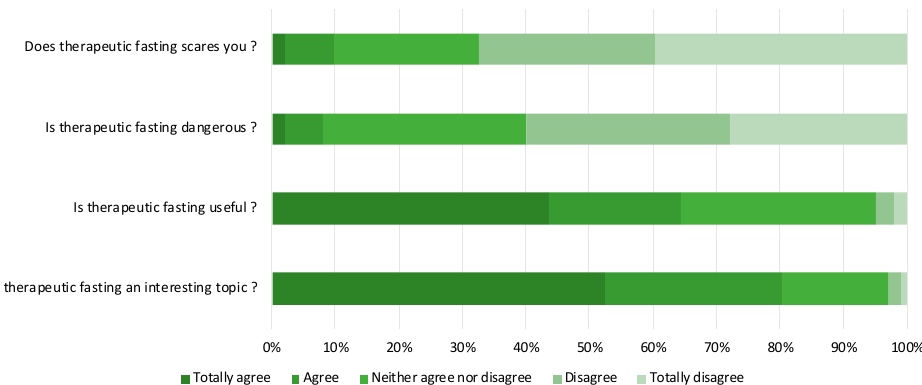
Figure 2. Perception of aged respondents about therapeutic fasting. Table 2. Relationship between age group and attitude towards fasting-mimicking diet-like (FMD- like).